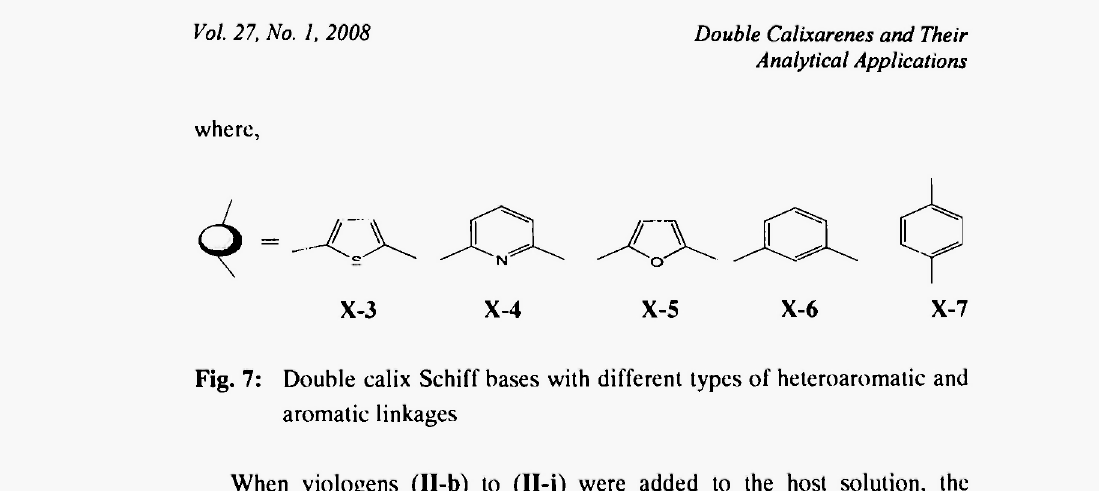
Fig. 7: Double calix Schiff bases with different types of heteroaromatic and aromatic